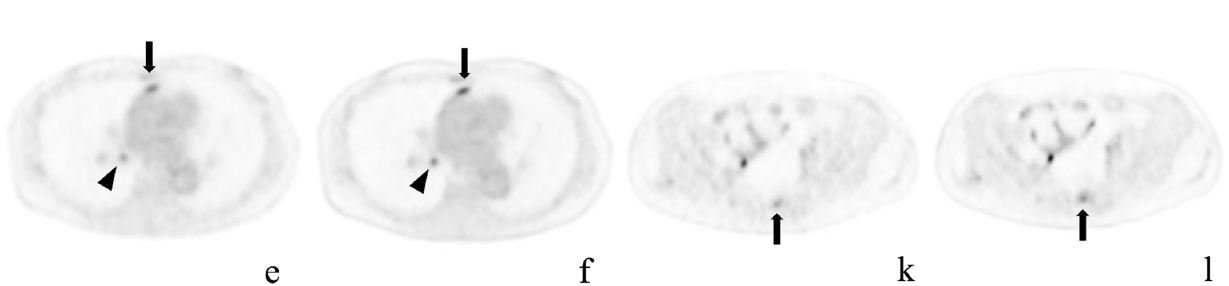
Figure 3. Representative cases. Axial positron emission tomography images with conventional Gaussian filtering ( a , c , e , g , i , k ) and those obtained with deep learning reconstruction ( b , d , f , h , j , l ). These pathological lesions were missed or were considered physiological uptake by OSEM imaging alone, but were detected on AiCE (DLR) imaging. ( a , b ) Forehead cutaneous nodule (arrows) in a 64-year-old woman; ( c , d ) Right superior pulmonary lobe (arrowheads) and superior mediastinal lymph node (arrows) in a 58-year-old man after surgery for thyroid cancer; ( e , f ) Anterior mediastinal (arrows) and right hilar (arrowheads) lymph node metastases in a 73-year-old woman with right inferior lung cancer; ( g , h ) Left adrenal adenoma in an 80-year-old man; ( i , j ) Enlarged para-aortic lymph node in a 41-year-old woman; k, l) Sacral metastasis (arrows) in the same patient.